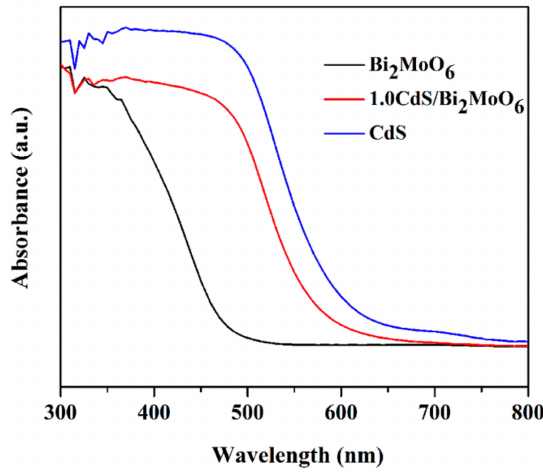
Figure 3. UV-vis absorbance spectra of bare Bi 2 MoO 6 , CdS, and 1.0CdS/Bi 2 MoO